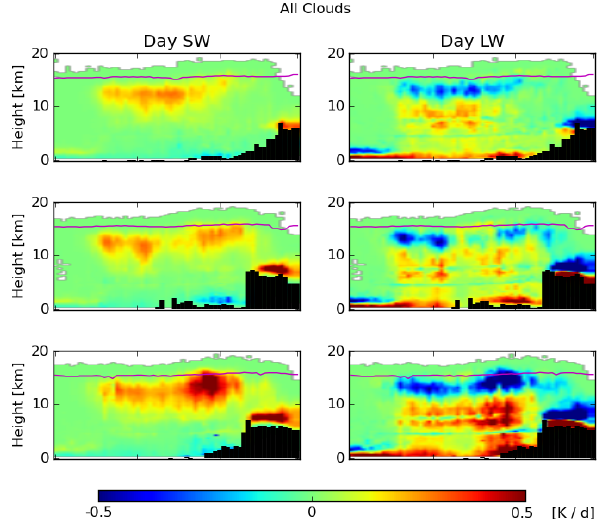
Figure 6. The vertical structure of CRH partitioned into its SW and LW components. All cloud types are included in the analysis and the data from 2006–2010 for the months June–September are used. The magenta-coloured lines show the level of zero net clear-sky radiative heating (LZRH).